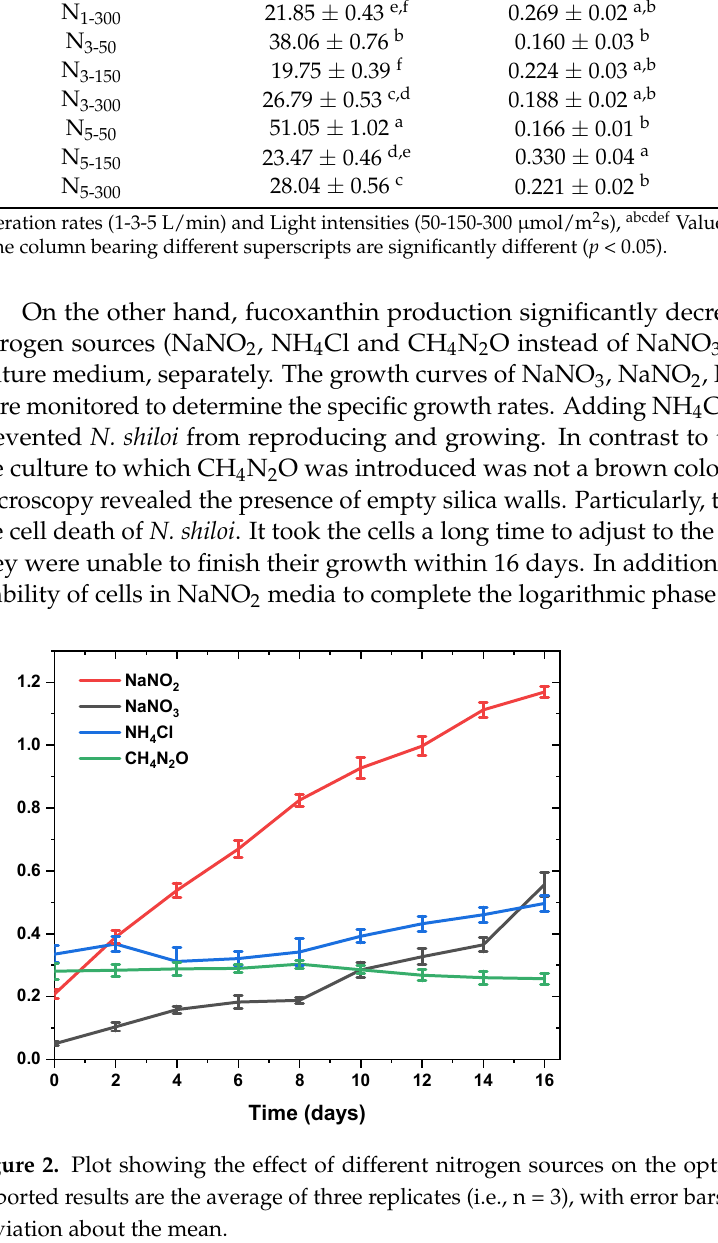
Table 1. Data for the production of N. shiloi and fucoxanthin amount under different light intensities and aeration rates. * Aeration Rate and